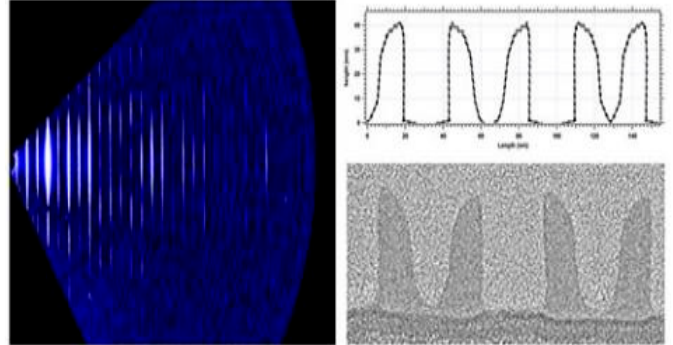
Figure 37. RSM and fits to the scattering profile of samples [250].